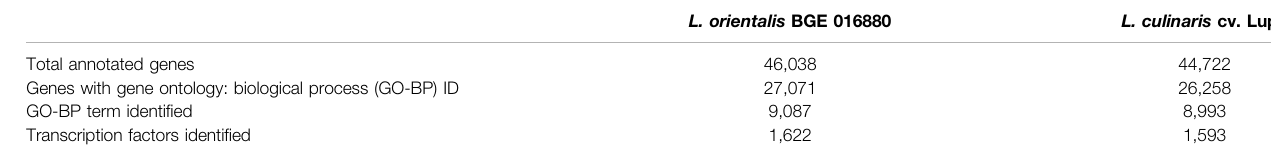
TABLE1| Summarystatisticsofgenesandtheirannotationsfrom denovo -assembledtranscriptomesof L.orientalis BGE016880and L.culinaris cv.Lupa.Totalannotated genes, the GO-BP ID, and terms were obtained through FunctionAnnotator (Chen et al., 2017), while transcription factors were identi fi ed using the Mercator pipeline (Lohse et al., 2014; Schwacke et al.,